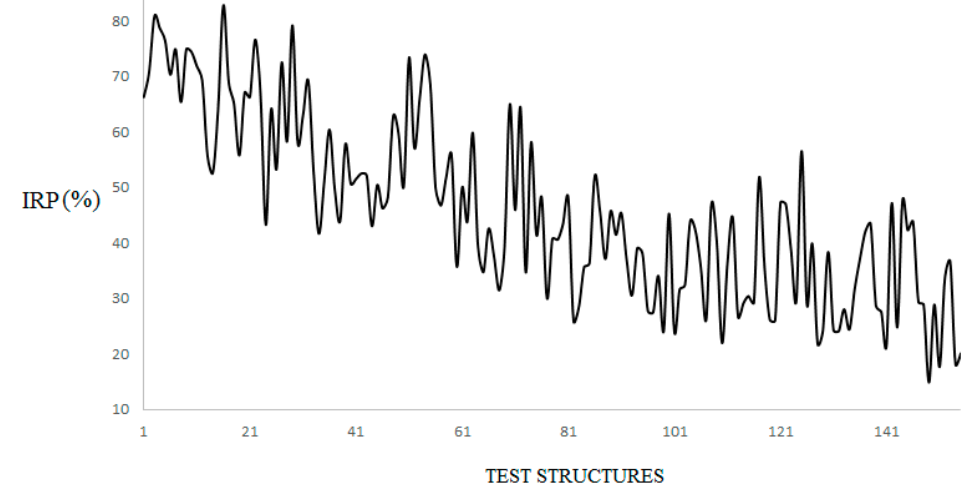
Figure 2. The percentage of independent reflections (IRP) value corresponding to each of the 155 test structures reported in Table 1.